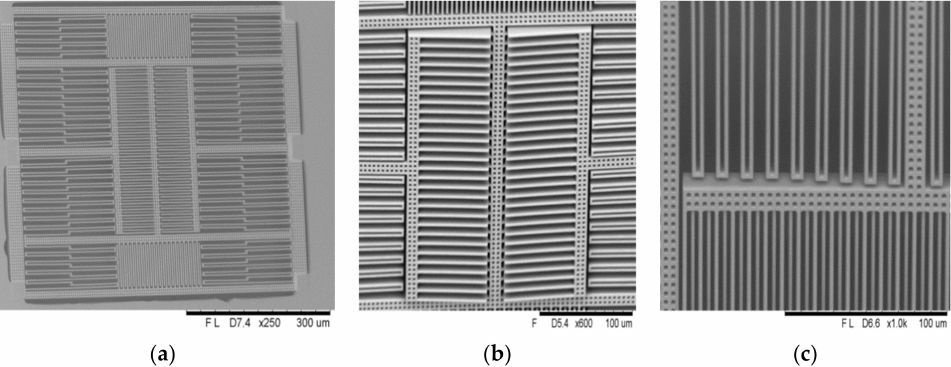
Figure 23. ( a ) Oblique SEM view of the MEMS structure; ( b ) zoomed-in view at the comb-finger; ( c ) zoomed-in view at the beam in the